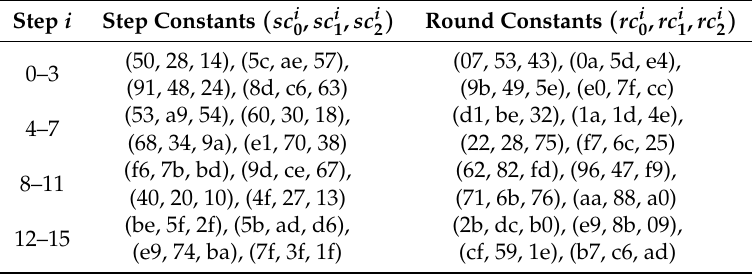
Table 1. Step and round constants of ACE